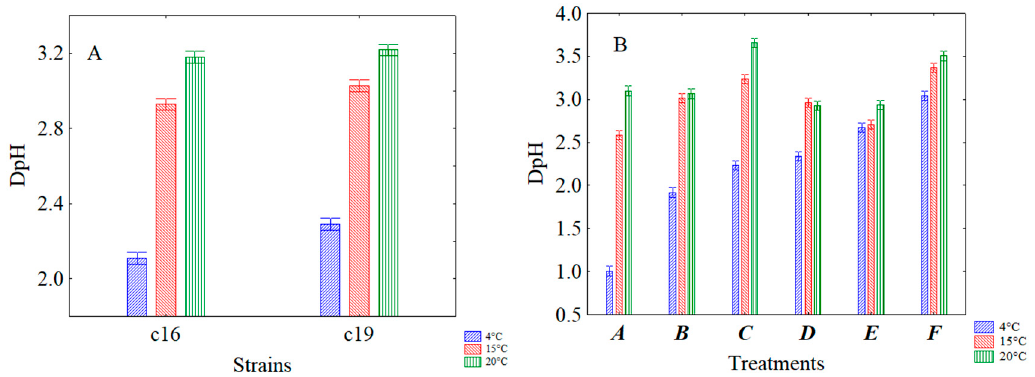
Figure 7. Decomposition of the statistical hypothesis for the interaction of the temperature vs strains ( A ) and vs treatments ( B ) on acidification. Bars denote 95% confidence intervals. Experiment on the effect of a thermal abuse in rice beverage for L. plantarum c16 and c19. For the code of US treatments see Table 2.